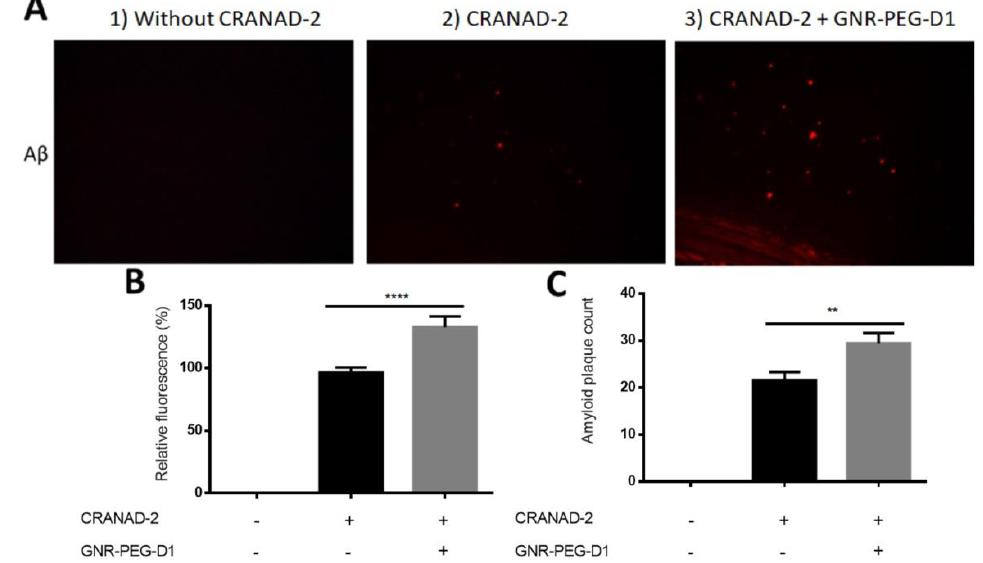
Figure 9. GNR-PEG-D1 presence enhances the fluorescent signal emitted by CRANAD-2. ( A ) Images of cortex histological sections of the Alzheimer’s disease (AD) model. From left to right: brain tissue prior to any treatment (1), incubated with CRANAD-2 0.24 mM for 5 min and washed with ethanol (2), and incubated with GNR-PEG-D1 0.001 nM for 5 min (3). ( B ) Quantitative and statistical analysis of the total number of images (n). ( C ) Count of amyloid plaques for the total number of images. Error bars represent SEM, n = 39. Mann–Whitney test was used for the statistical analysis. ** p = 0.0011, **** p < 0.0001.